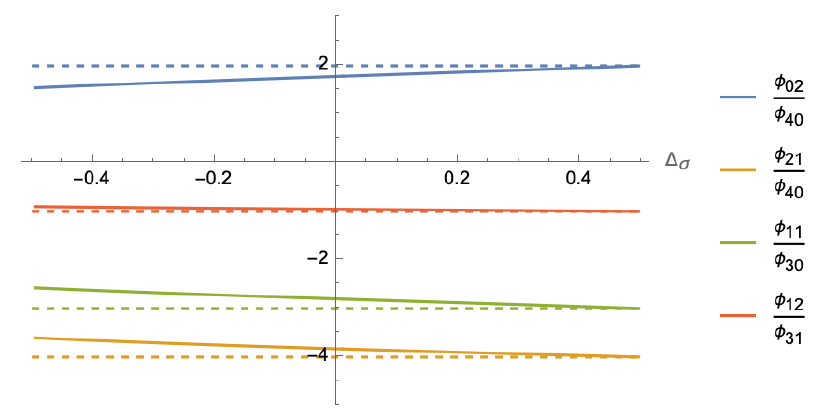
Figure 5: Universality φ in the ratios of the Wilson coefficients. The plots are using the exact answers (solid) and match well with the LTD prediction (dashed). Fig.(4) explains the small deviations from the